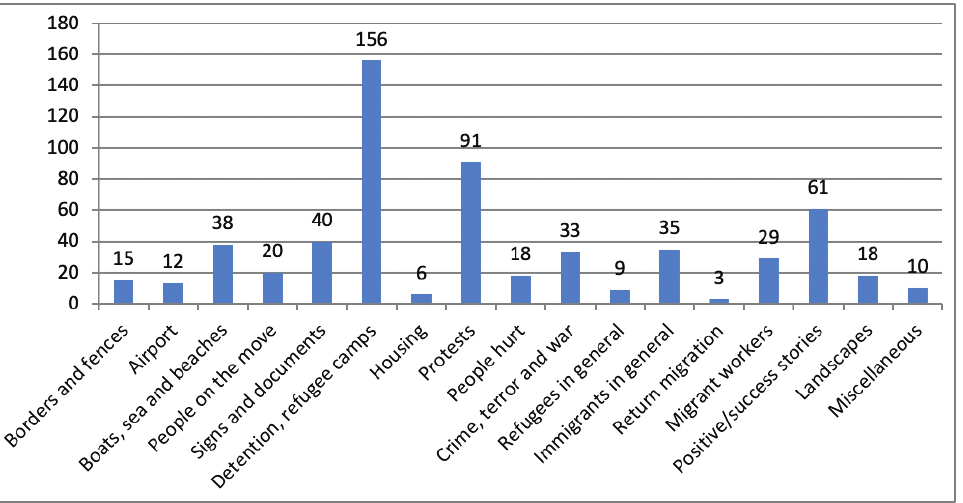
Figure 1: Number of images depicting migration, grouped